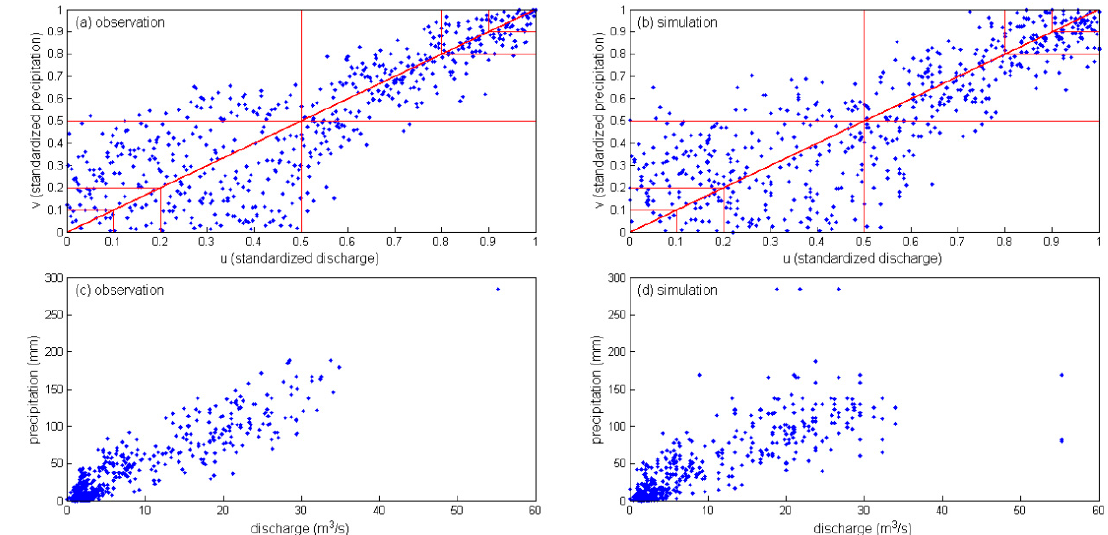
Figure 8. The observation and simulation data points between precipitation and discharge before and after standardization. u denotes the standardized discharge and v is the standardized precipitation. The panels ( a , b ) are the scatter diagrams of observed and simulated discharge and precipitation after standardization and the panels ( c , d ) are the scatter diagrams of observed and simulated discharge and precipitation without standardization. Table 2. The frequency statistics of observed and simulated data points in different